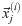
Process of generating weekly stock feature vector and feature matrix.The lower half in this figure shows the backtracking window, which is generated by time series. In the upper half of this figure, x→j(i) and Xw×m(j) represent weekly stock feature vector and feature matrix at the trading date ti, respectively. Xw×m(1),Xw×m(2),...,Xw×m(p) and Gk×m(ti) represent all stock feature matrices in the stock universe and a stock selection target matrix generated by Algorithm 1 at the trading date ti, respectively.